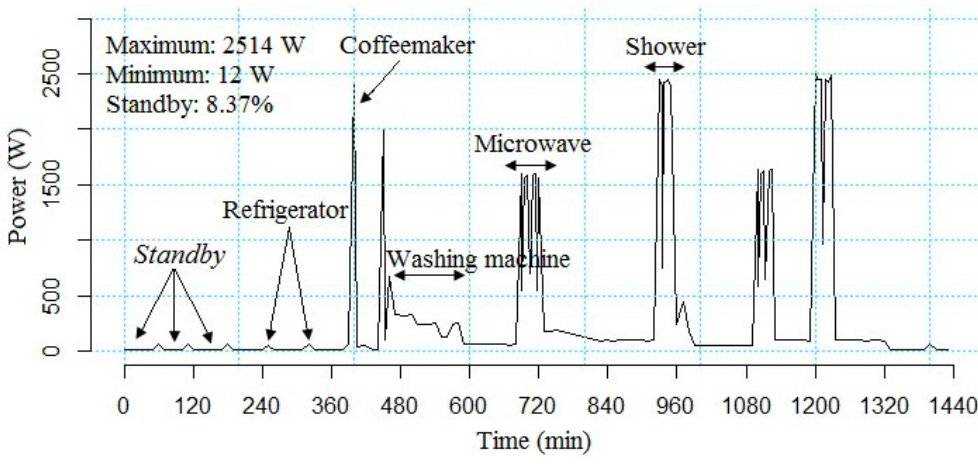
Figure 8. Using the platform developed to observe the energy consumption in terms of waste by the user over a period of 24 h and identifying the idle equipment, those which, for example, remain for a considerable time in standby